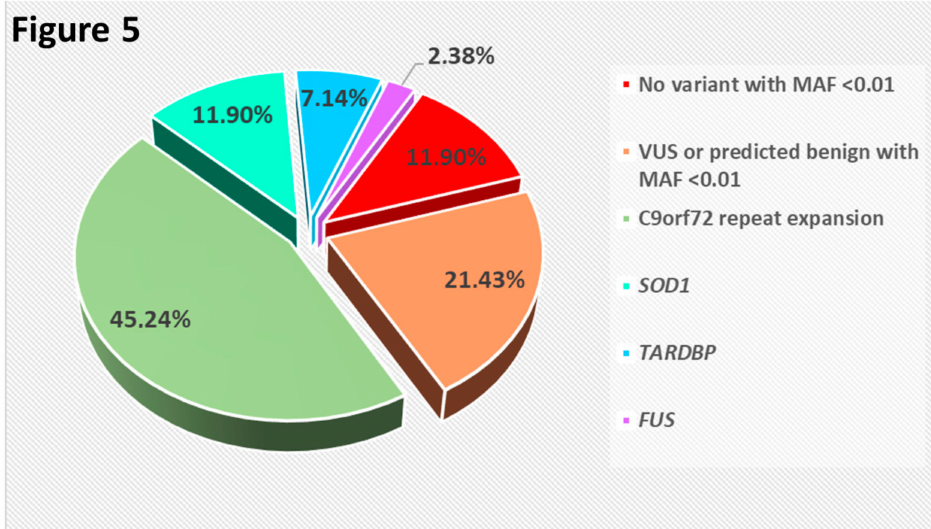
Figure 5. Pie chart showing the distribution of familial ALS cases in which we identified either a pathogenic variant in one of the indicated genes, or at least one sequence variant with MAF < 0.01 not classified as pathogenic or likely pathogenic, or no variant with MAF < 0.01 at all. (VUS: Variant of uncertain